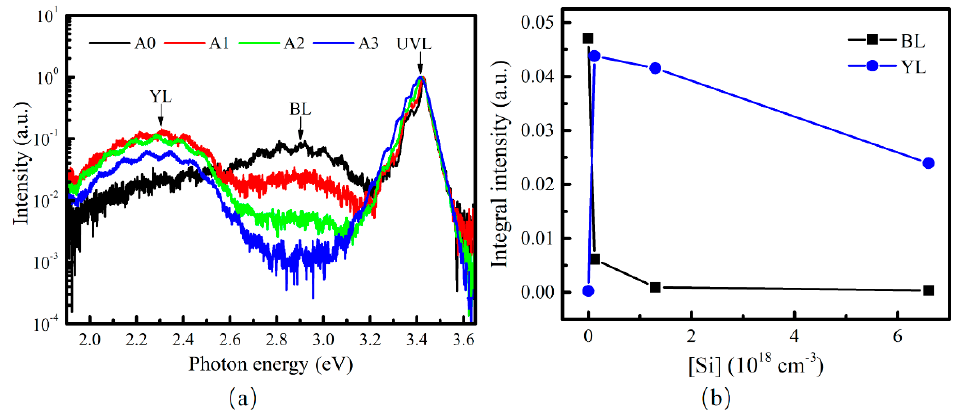
Figure 5. ( a ) Normalized room temperature PL spectra; and ( b ) the dependences of integral intensities of BL (square) and YL (circle) bands on the Si concentration based on the data points of samples A0, A1, A2 and A3 (from left to right).